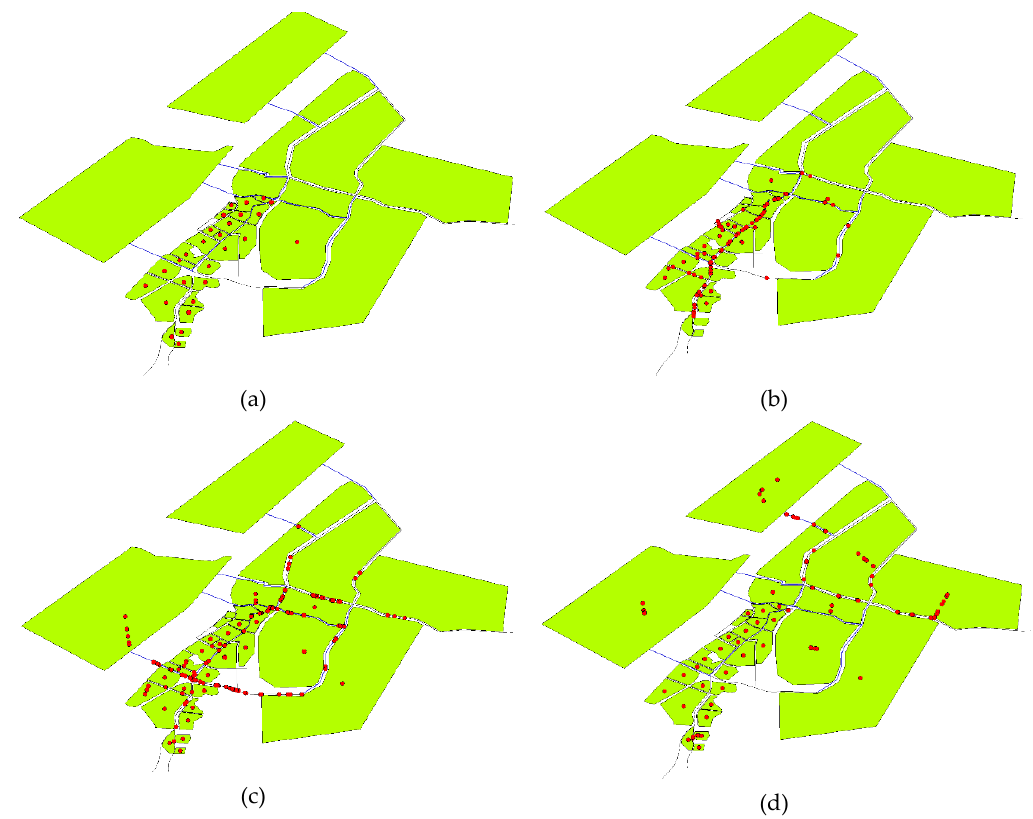
Figure 5. Real-time screenshots during model running and simulation. ( a ) Run time 30 s; ( b ) Run time 900 s; ( c ) Run time 1800 s; ( d ) Run time 3200 s.